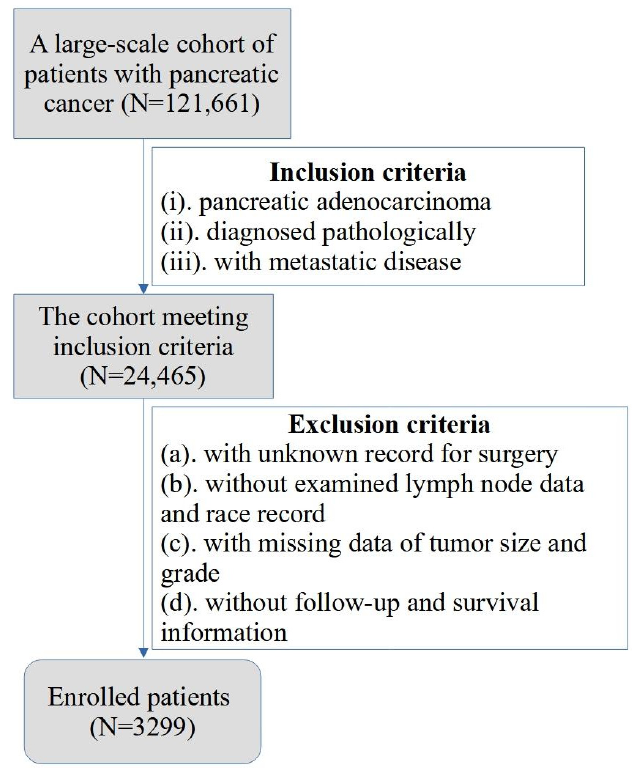
Figure 1. The flowchart for the process of patient screening.